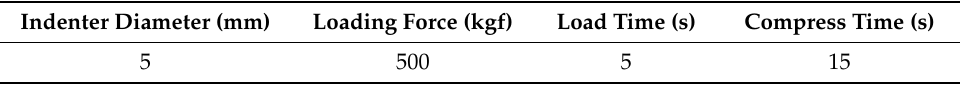
Table 4. Basic test parameters for hardness